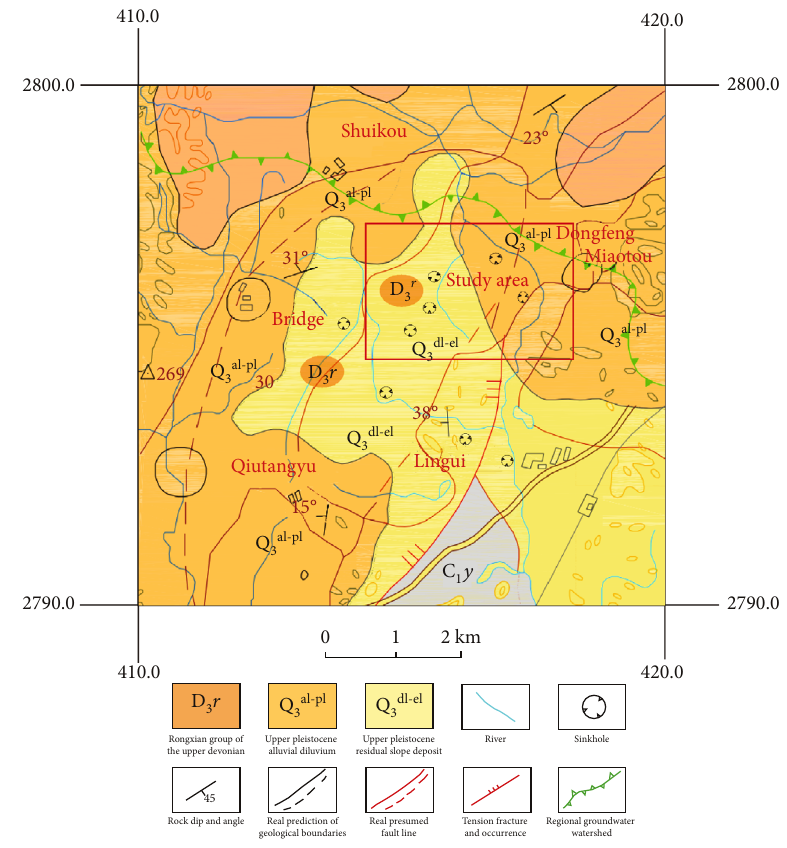
Figure 1: Engineering geological map.